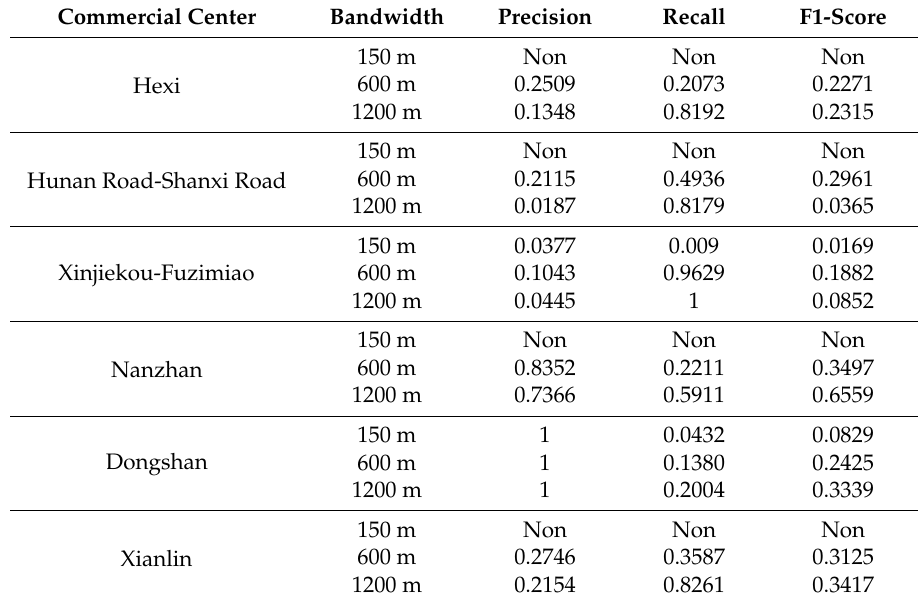
Table 8. Accuracy comparison of the extraction results with 150-m, 600-m, and 1200-m bandwidth. Commercial